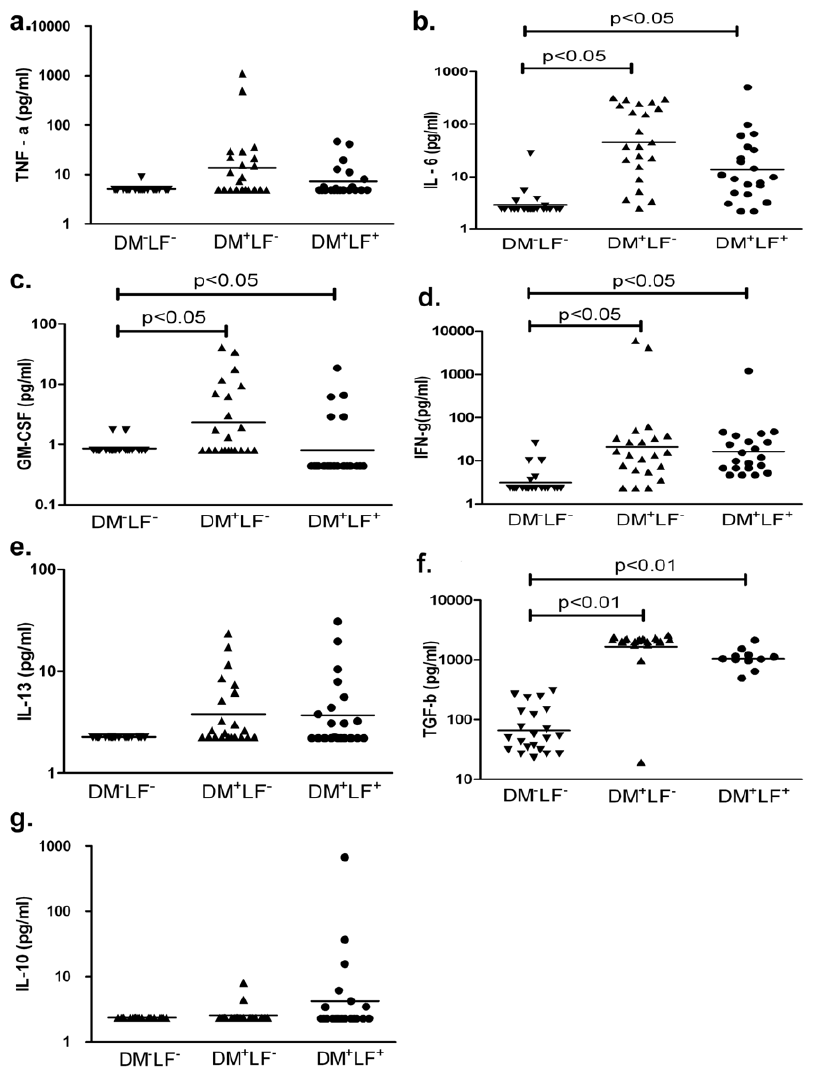
Figure 3. Pro- and anti - inflammatory serum cytokine levels in control (DM 2 LF 2 ), diabetes alone (DM + LF 2 ) and diabetes and LF (DM + LF + ) subjects. Serum levels of TNF- a (Panel a), IL-6 (Panel b), GM-CSF (Panel c), IFN- c (Panel d), IL-13 (Panel e), TGF- b (Panel f) and IL-10 (Panel g) are shown. Each dot represents an individual patient, with the geometric mean represented by the horizontal bars. p values were calculated by multinomial logistic regression